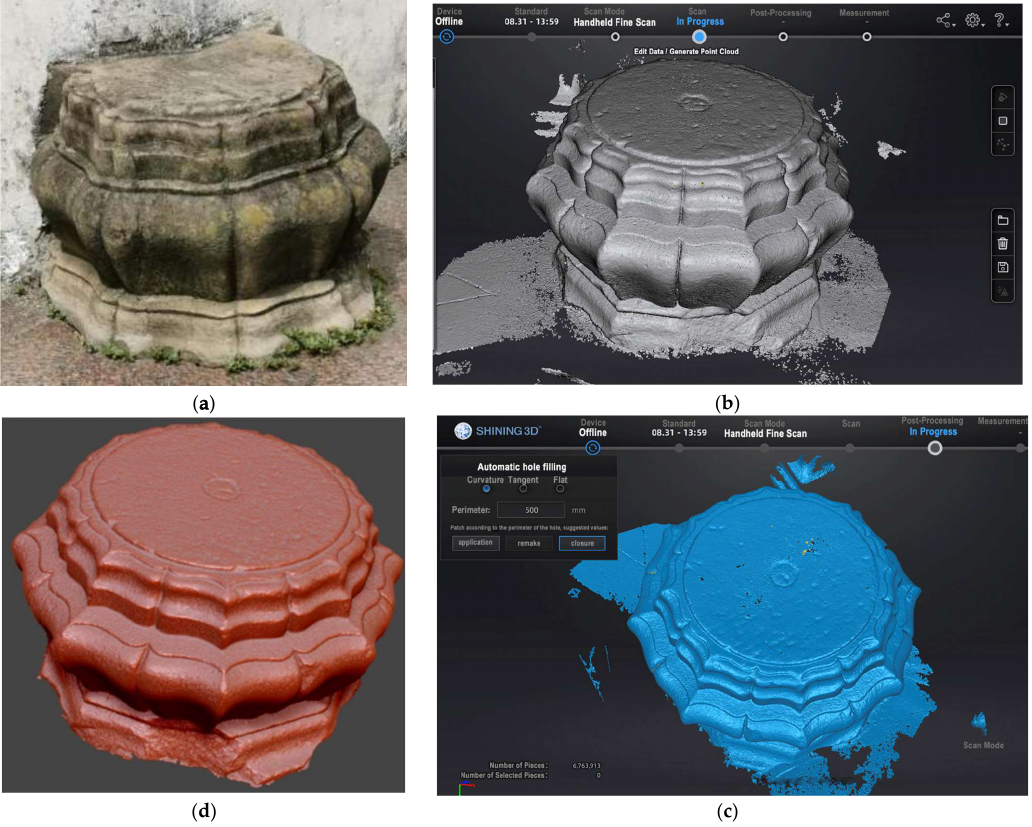
Figure 3. ( a ) Stone plinth cultural relics; ( b ) scanned point cloud data of stone plinth; ( c ) patching point cloud data; ( d ) plinth digital model. point cloud data; ( d ) plinth digital